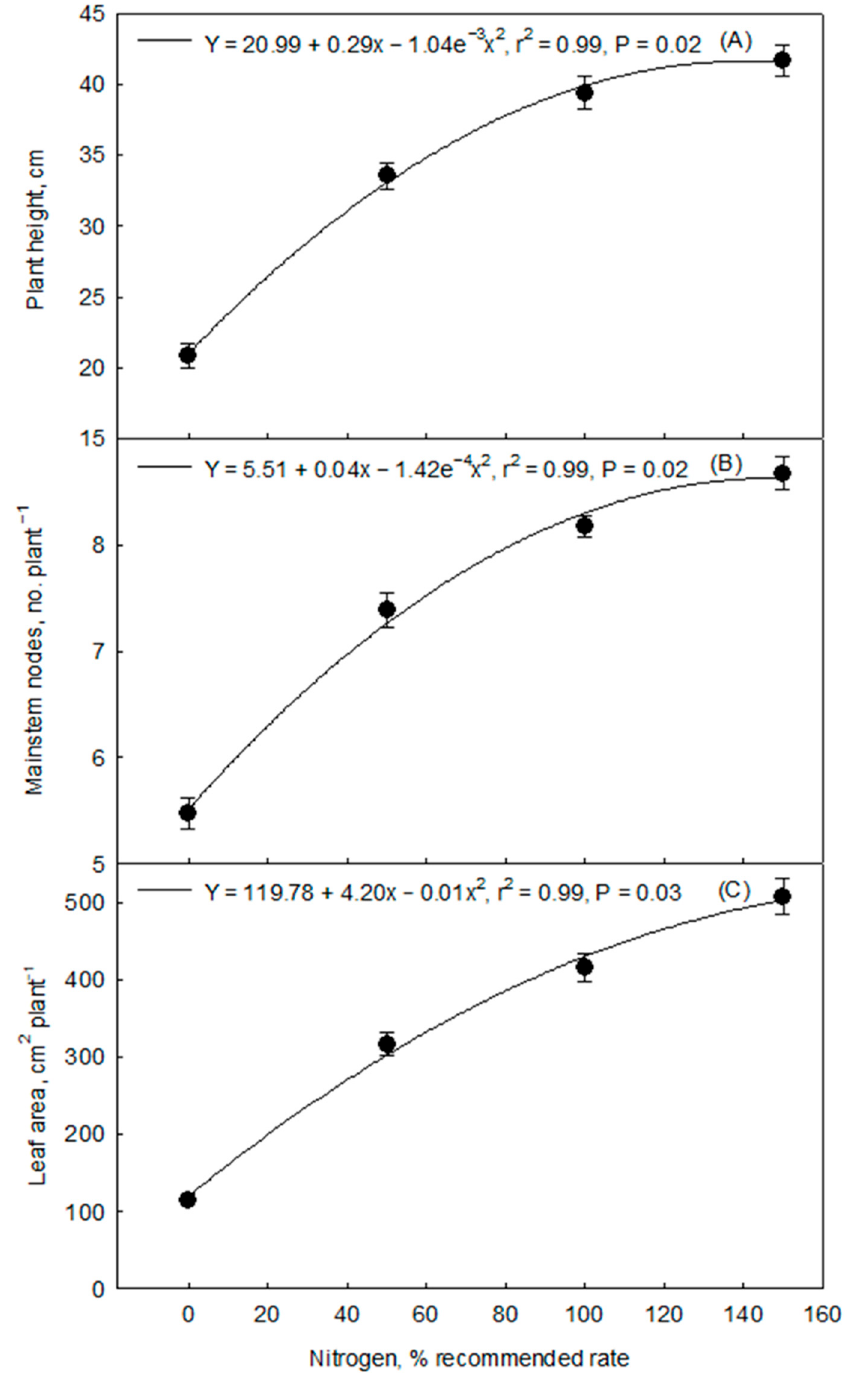
Figure 5. Nitrogen treatment effect on plant height ( A ), main stem node number ( B ), and leaf area ( C ) of cotton at 60 days after planting. Data are means ± Standard error ( n = 64plants in total for fourreplications and two runs).